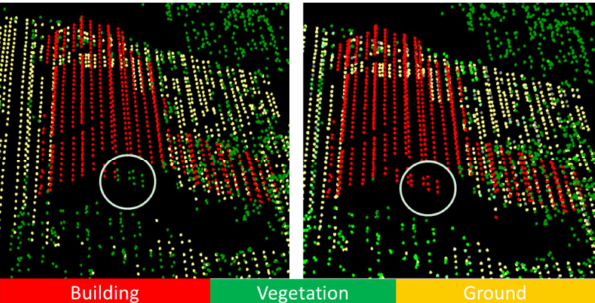
Figure 1. Classification result for building detection: result from point-wise likelihood analysis ( left ), and result from energy minimization combining point-wise likelihood and pair-wise spatial coherence ( right ) The building points are further processed to create a triangulated irregular network (TIN) graph and the long edges are eliminated to cut off connections among different buildings. Connected-component labelling is then performed on the undirected graph to isolate rooftops. While points within boundaries are reserved to derive polygonal shape, inside points are considered as redundant observations and removed. The 2D α -shape algorithm (Bernardini and Bajaj, 1997) is employed to delineate the building boundary, where the value of α is defined as 1.5 times of the average point